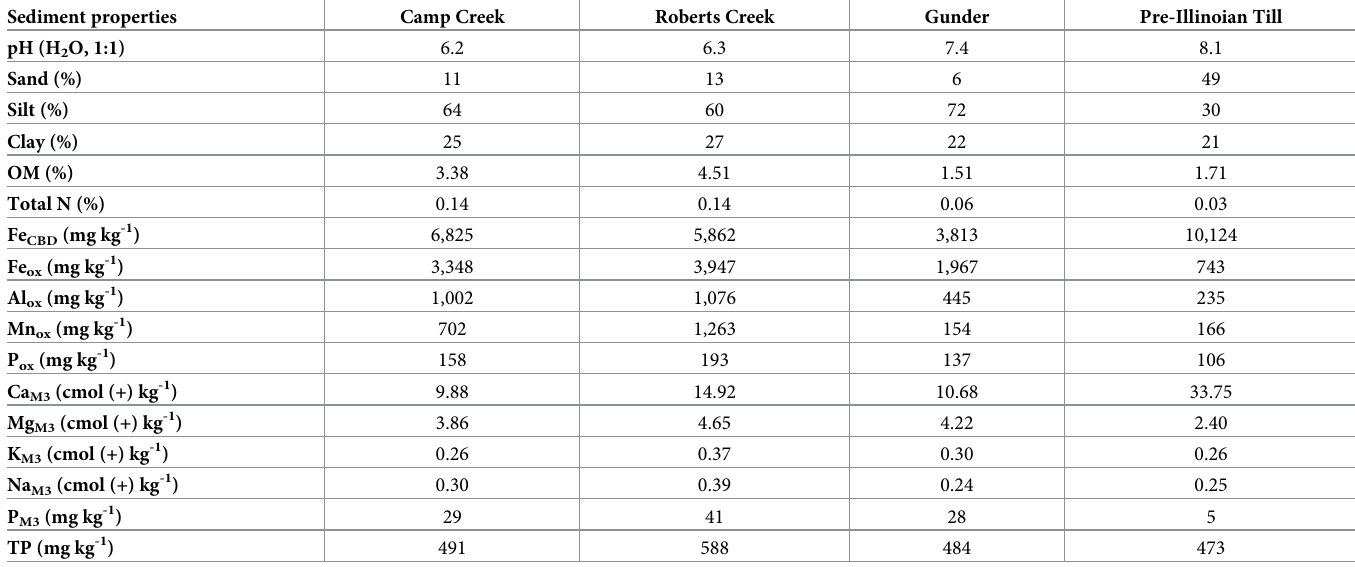
Table 1. Selected sediment properties, where OM = organic matter, TP = total P, Fe ox /Al ox /Mn ox /P ox = ammonium oxalate extractable Fe/Al/Mn/P, Fe CBD = citrate bicarbonate dithionite extractable Fe,